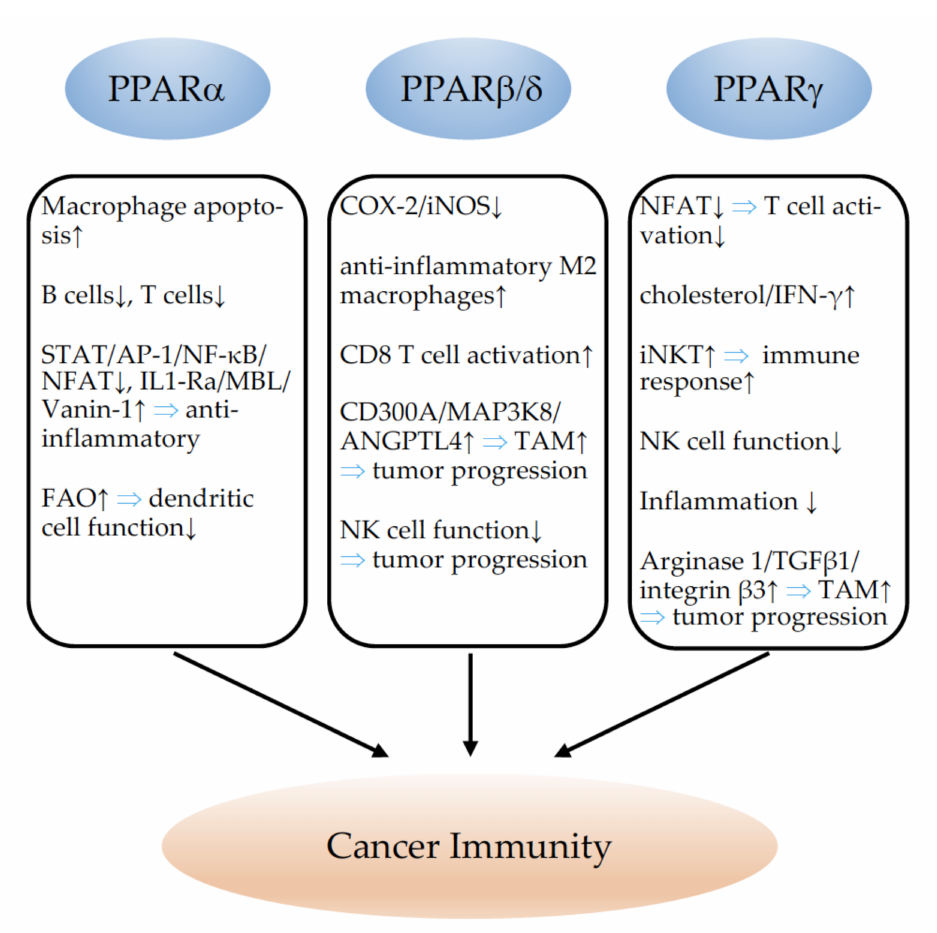
Figure 8. Effects of PPAR α , PPAR β / δ , and PPAR γ on cancer immunity. ↓ indicates inhibition